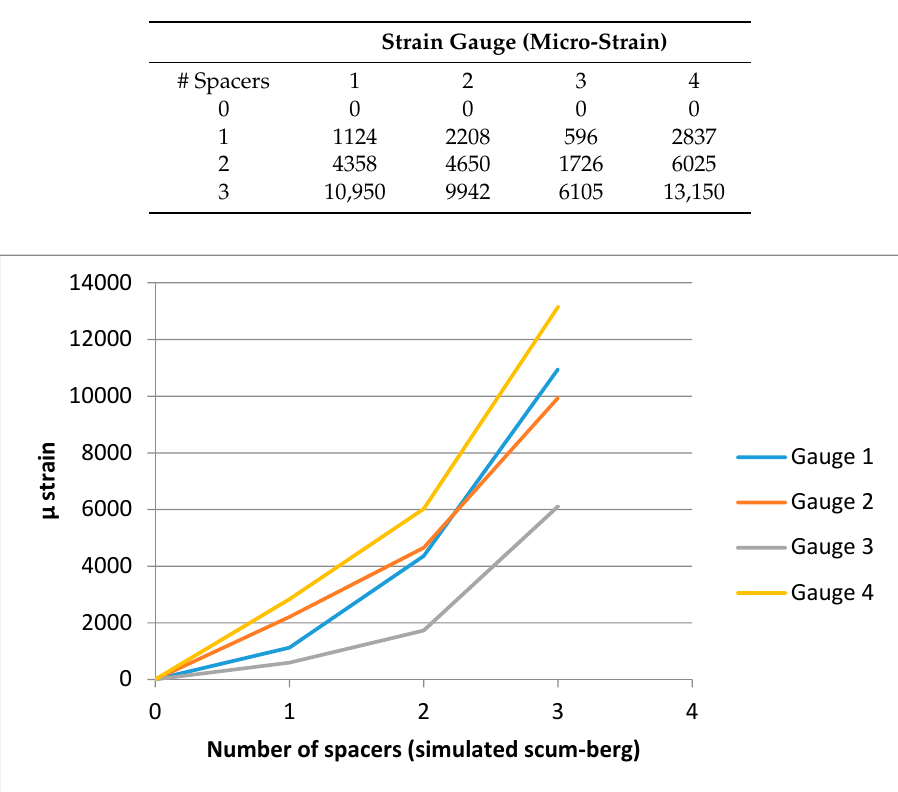
Figure 14. Geometry of the test membrane subjected to vertical deformation arising from the simulated scum-berg obtained from 3D scanning. Table 2. Strain readings from the strain gauges.